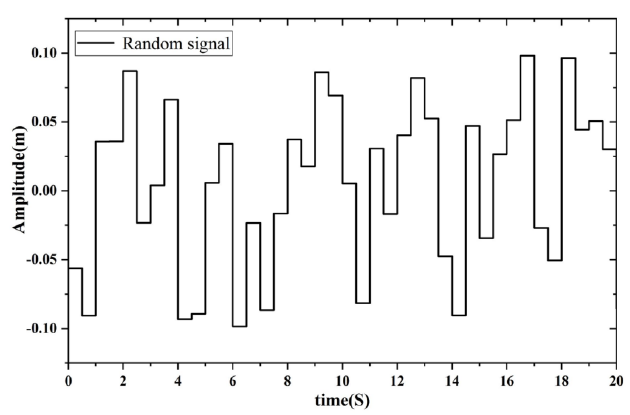
Figure 5. Random Figure 5. Random offset.